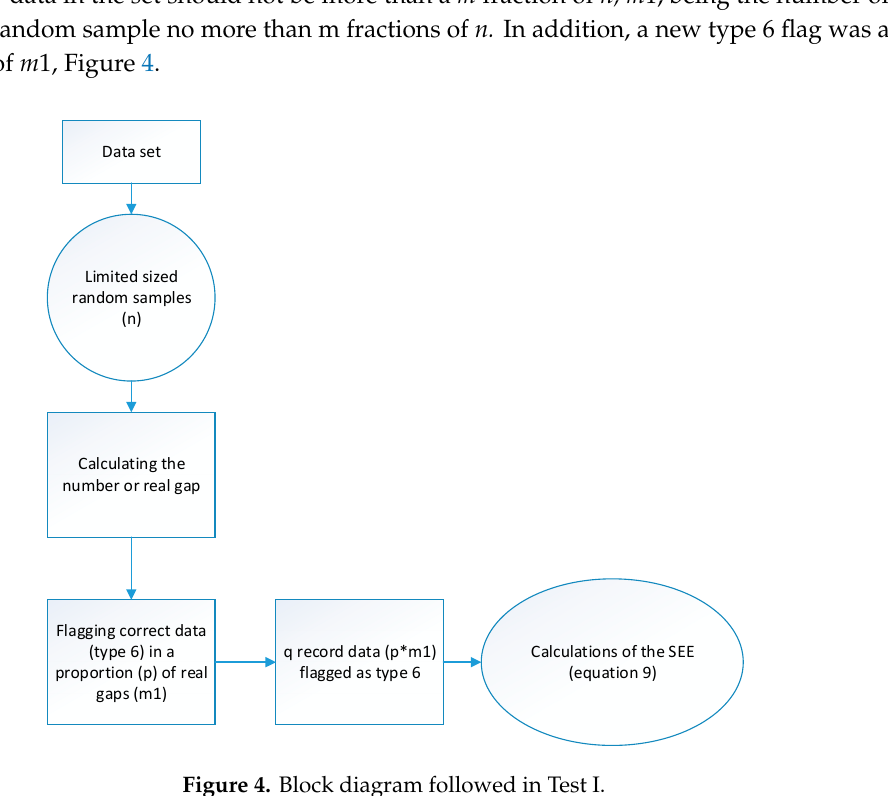
Figure 4. Block diagram followed in Test I.